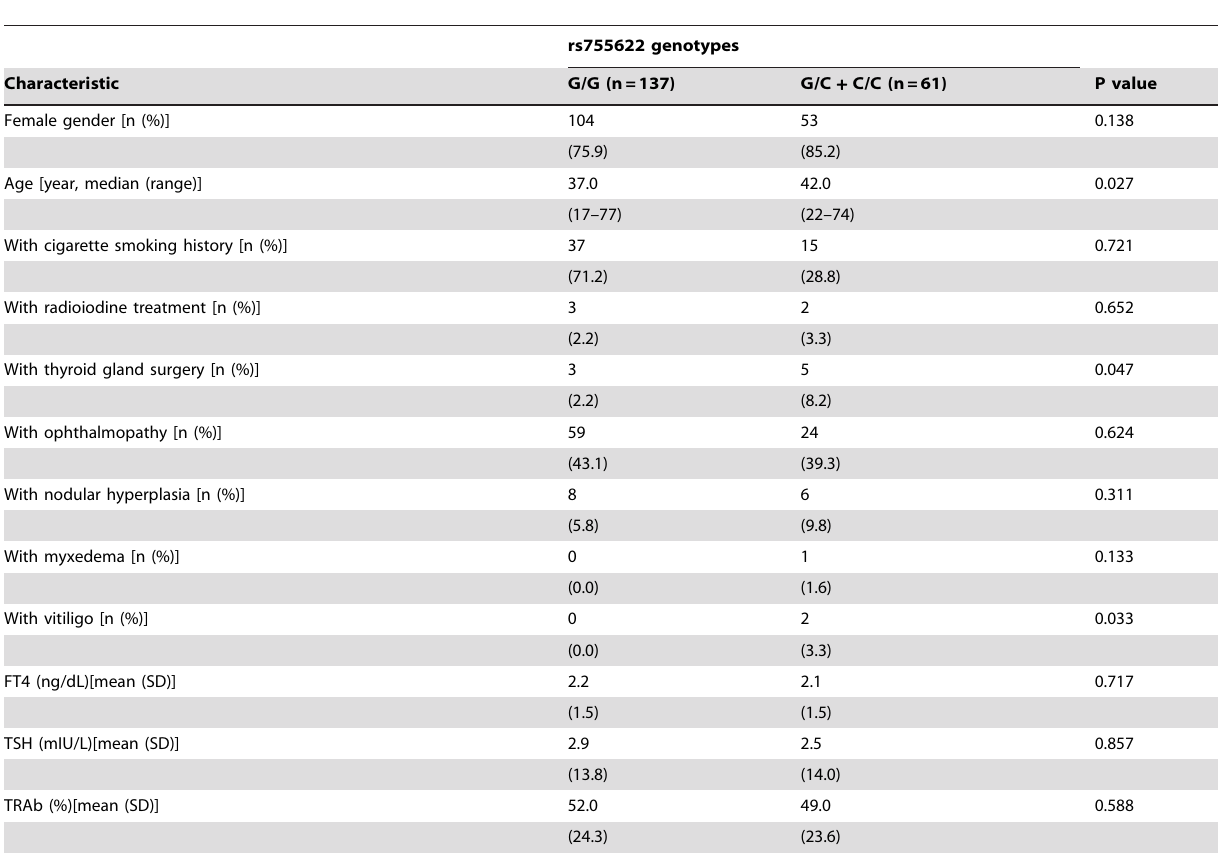
Table 5. Clinical significance of MIF genotype in patients with untreated Graves disease.